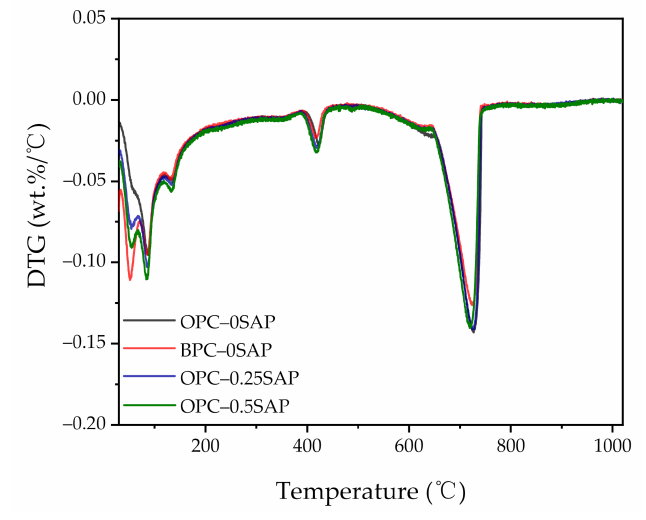
Figure 13. Derivative thermogravimetric analysis (DTG) curves of all samples.